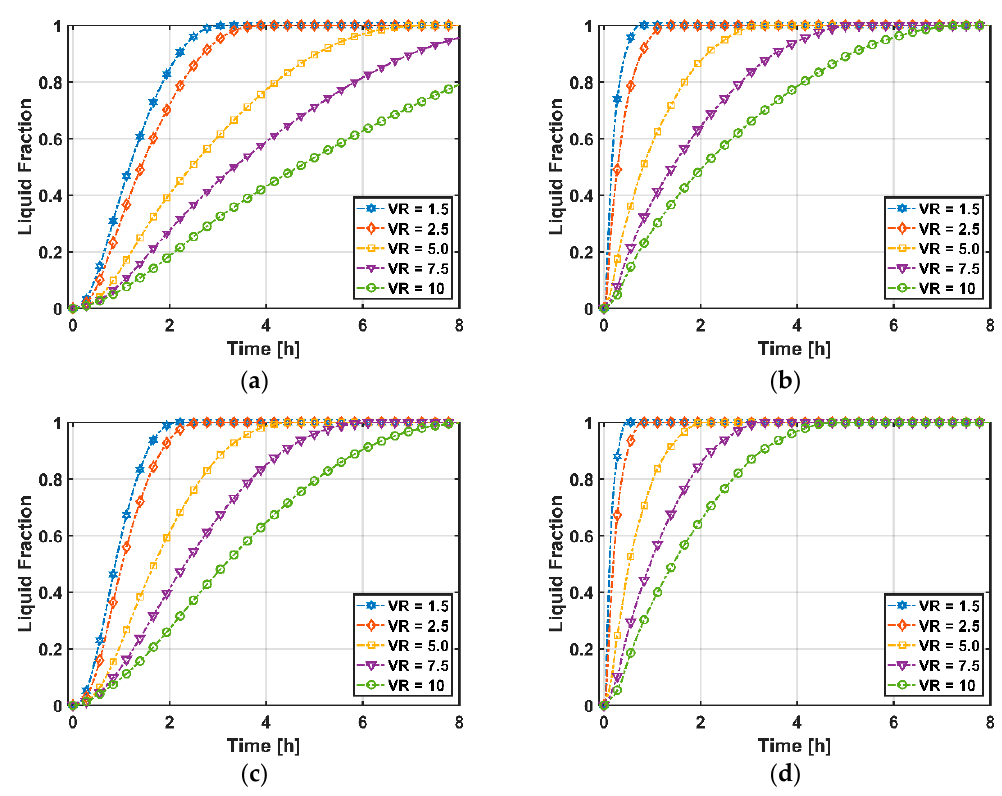
Figure 12. Liquid fraction profile for initial PCM - HTF temperatures of ( a ) 418–460 K (VFR = 0.3 m 3 /h), ( b ) 418–460 K (VFR = 3.8 m 3 /h), ( c ) 403–473 K (VFR = 0.3 m 3 /h) ( d ) 403–473 K (VFR = 3.8 m 3 /h).